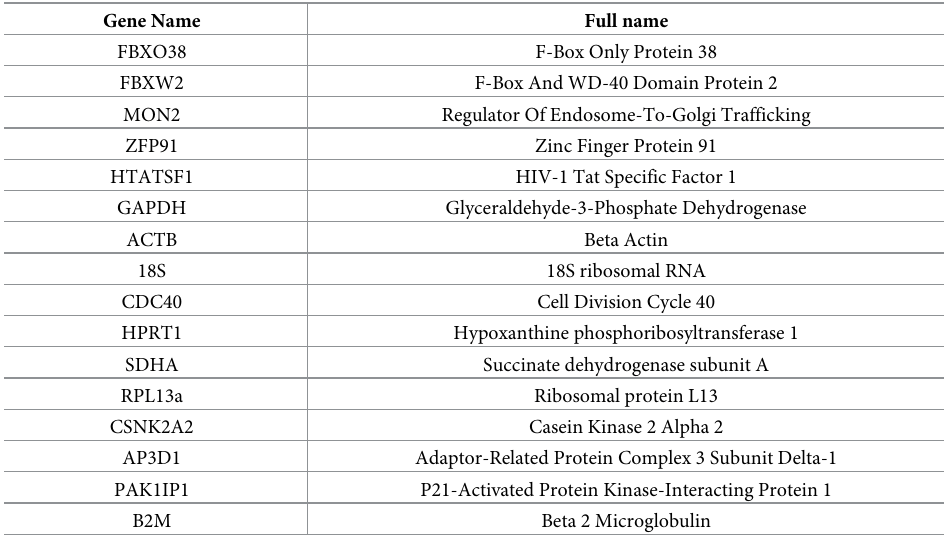
Table 1. Candidate reference gene names/full